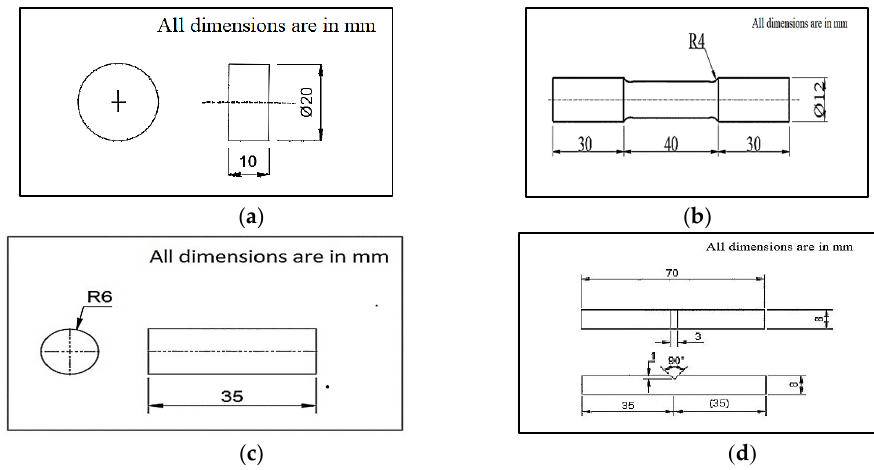
Figure 2. Mechanical characterization as ASTM standards used: ( a ) hardness test specimen dimension [ASTM E92-82]; ( b ) tensile test sample dimension [ASTM E8]; ( c ) wear test specimen dimension [ASTM G99]; ( d ) impact test sample dimension [ASTM